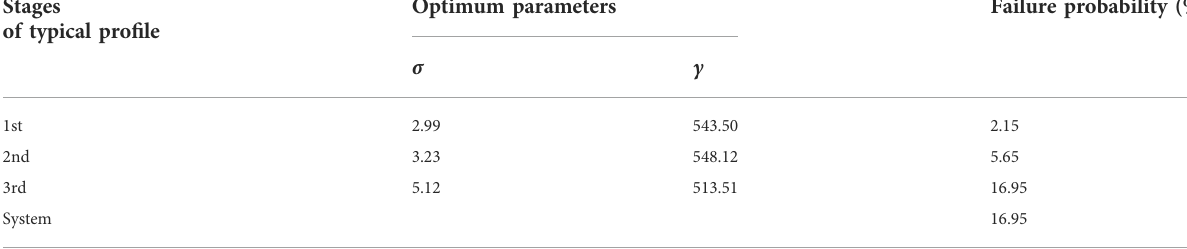
TABLE 2 Calculation results of intelligent multiple response surfaces for the Zhenggang landslide. Stages of typical pro fi